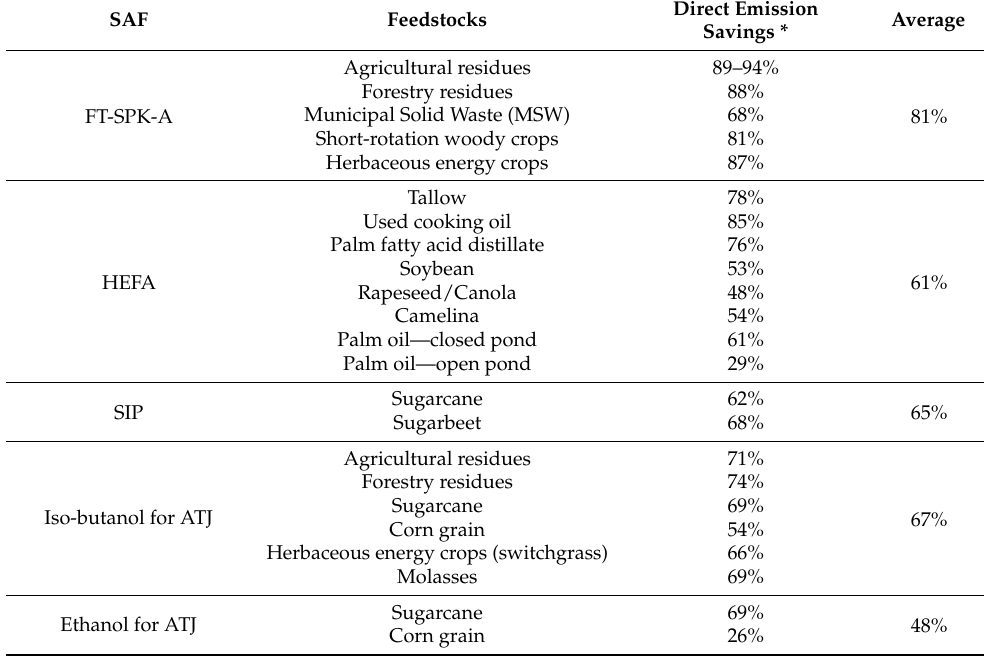
Table 2. Greenhouse emissions savings (excluding carbon emissions from land use change)